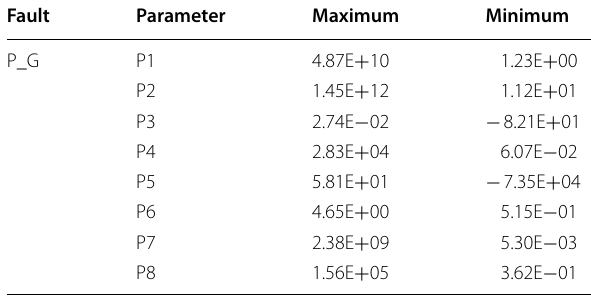
Table 1 PG short circuit fault ranges